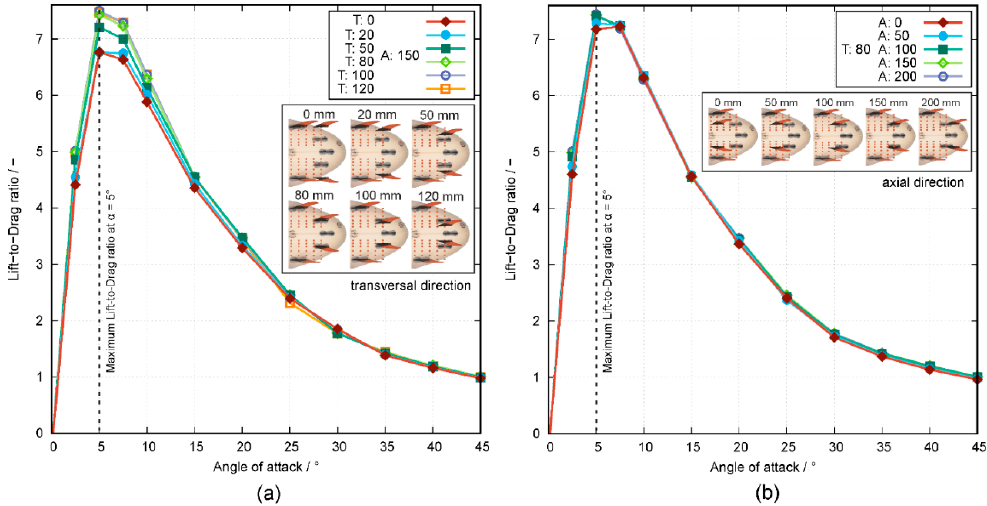
Figure 16. ( a ) Lift-to-drag ratio versus the angle of attack for six entire fin configurations. The rear fins are fixed in one axial position and shifted in six positions of the transversal direction of the surfboard. ( b ) the lift-to-drag ratio versus the angle of attack for five entire fin configurations. The rear fins are fixed in one transversal position and shifted for five positions of the axial direction of the